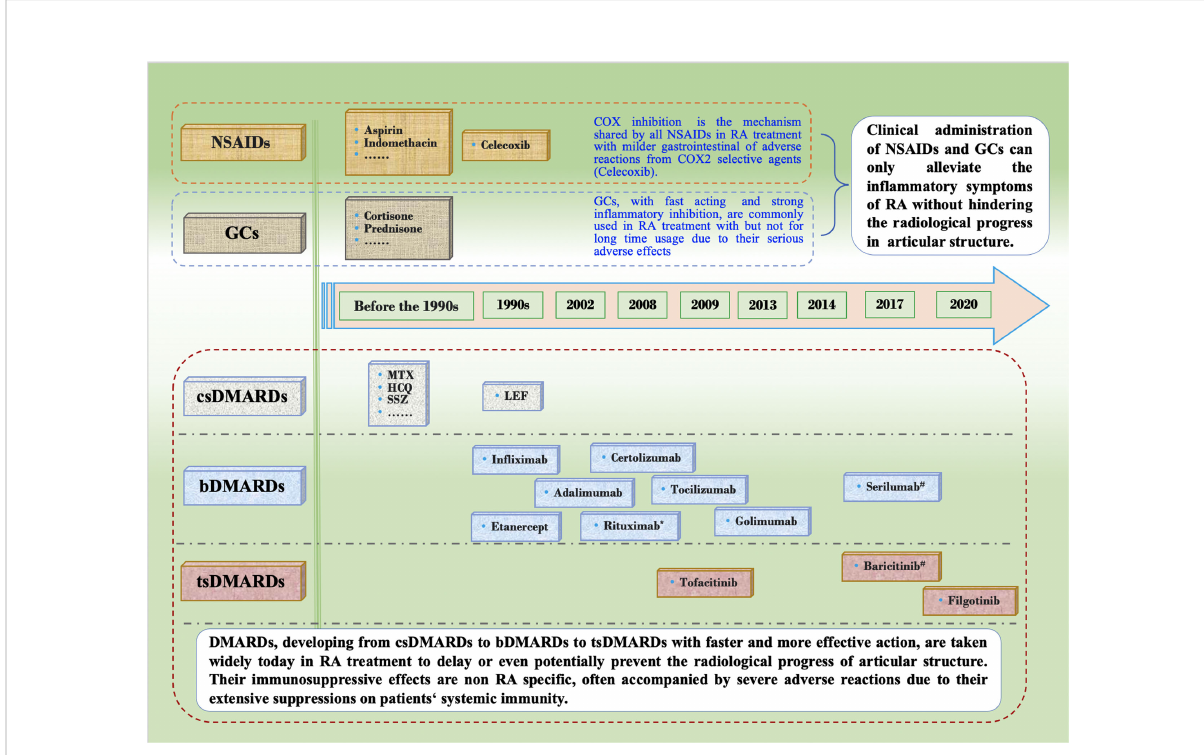
FIGURE 1 Development of Conventional Agents in the Treatment of Rheumatoid Arthritis. NSAIDs and GCs have stagnated for more than 20 years mainly due to their mere ability to alleviating RA in fl ammatory symptoms without interfering with the progress of articular erosion. Since DMARDs was proven to be able to slow down the erosive progress, they have been widely used in RA treatment as essential drugs, and have developed from csDMARDs to bDMARDs to tsDMARDs. Choice of csDMARDs, also known as slow acting antirheumatic drugs with non-targeted immunosuppressive effect, have remained the same for the last two deacdes. hbDMARDs, composed of recombinant monoclonal antibodies and receptors of proin fl ammatory cytokines, were rigorously developed in about the 2000s. tsDMARDs, targeting intracellular various signaling pathways, are becoming widely used in the recent 10 years due to its fast onset, high effect and more convenient oral medication. However, the immunosuppressive effects of all conventional medications above are not RA speci fi c, and therefore cannot correct the autoimmune disorder to cure RA while they have the risk of serious adverse reactions after long-term use. Restoring the disordered autoimmune balance by reconstruction of RA speci fi c immune tolerance is an ideal approach to cure RA. *, approved fi rstly by Food and Drug Administration (FDA) of USA for refractory RA treatment in 2006. # , approved by European Union but not FDA for RA treatment. NSAIDs, non-steroidal anti- in fl ammatory drugs; GCs, glucocorticoids; DMARDs, disease modifying anti-rheumatic drugs; csDMARDs, conventional synthetic